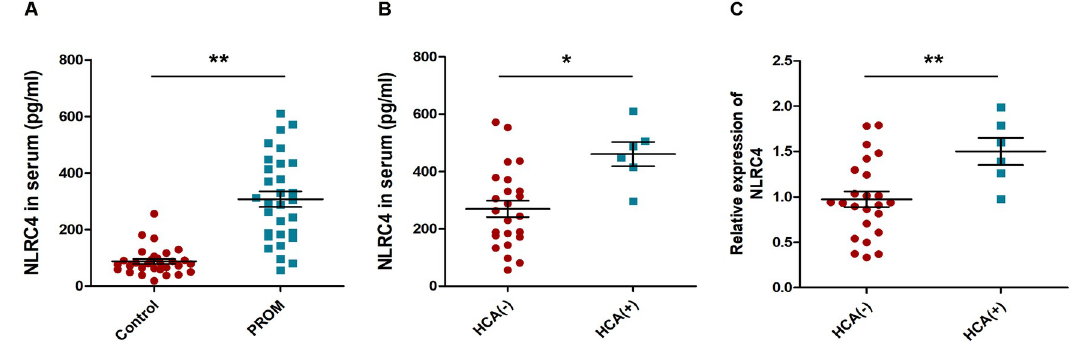
Fig 4. Evaluation of NLRC4 in Maternal Blood serum for Prediction of PROM. (A) ELISA assay of the NLRC4 level in maternal blood serum, �� P < 0.01 vs the indicated group, n = 30; (B, C) Detection of NLRC4 level in PROM patients and PROM combined with HCA patients by ELSIA assay and RT-PCR, � P < 0.05, �� P < 0.01 vs the indicated group, n = 30.